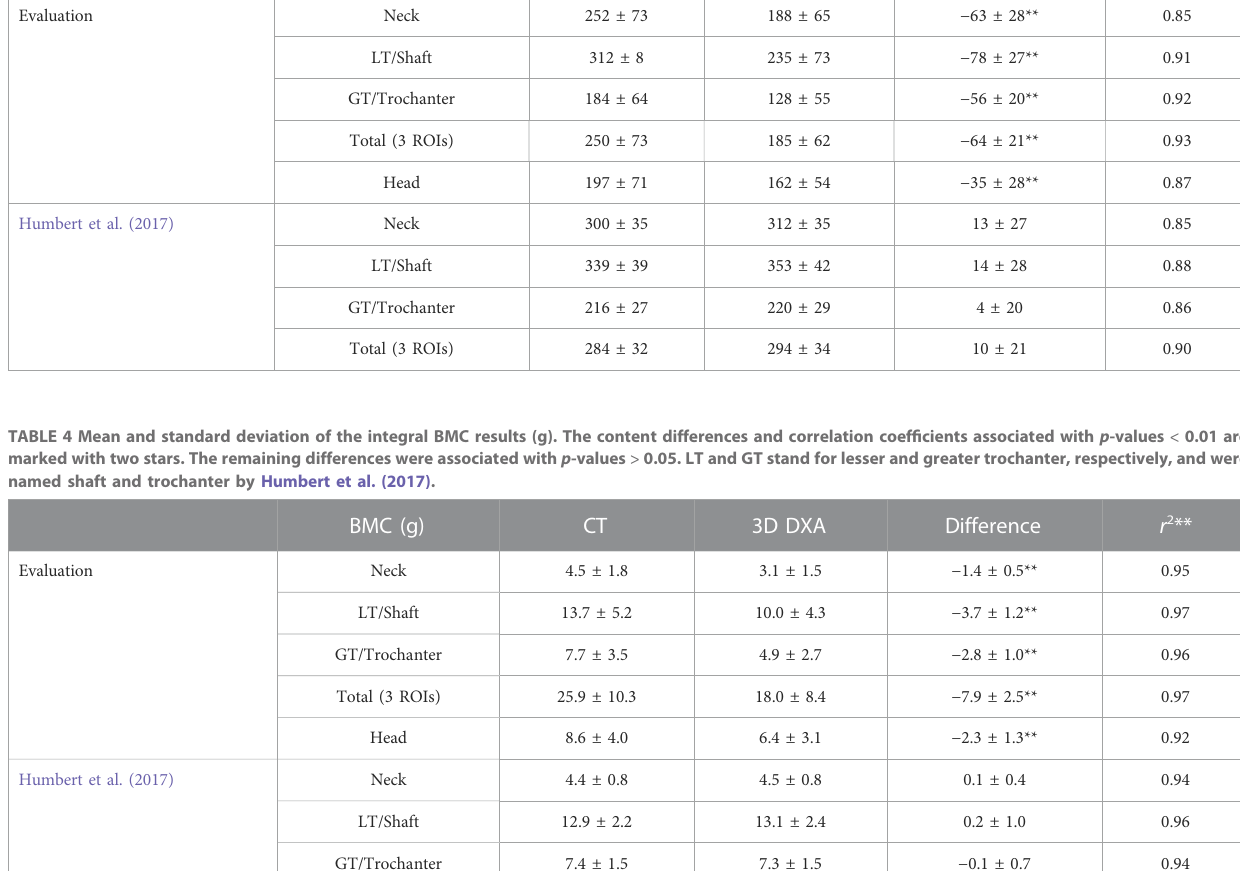
neck cortex, with differences of up to 620 mg/cm 3 . The two lines visible in the shaft cortex could indicate that the cortical thickness or position does not match between CT and 3D DXA.